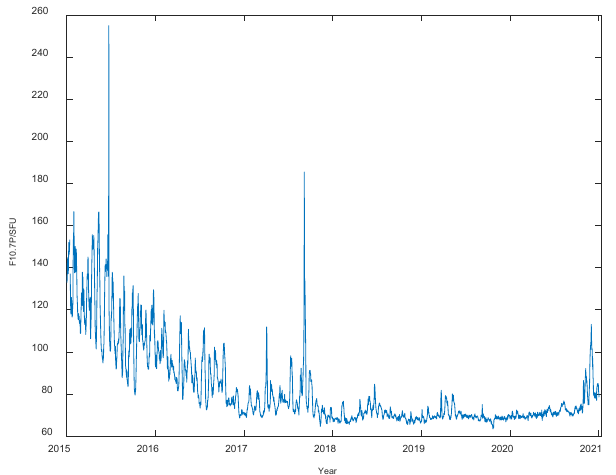
Table 1. Geographic longitude, latitude and magnetic declination/inclination of the chosen GIMs grid point.